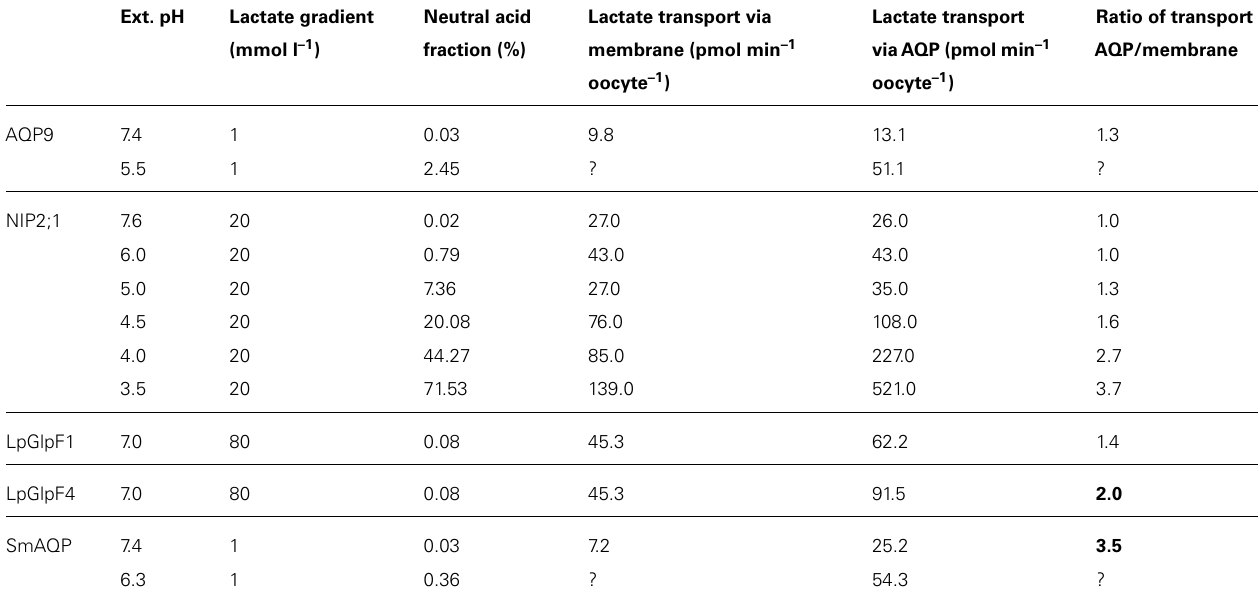
Table 2 |Assay conditions and observed increase ofAQP facilitated lactate transport. Ext.